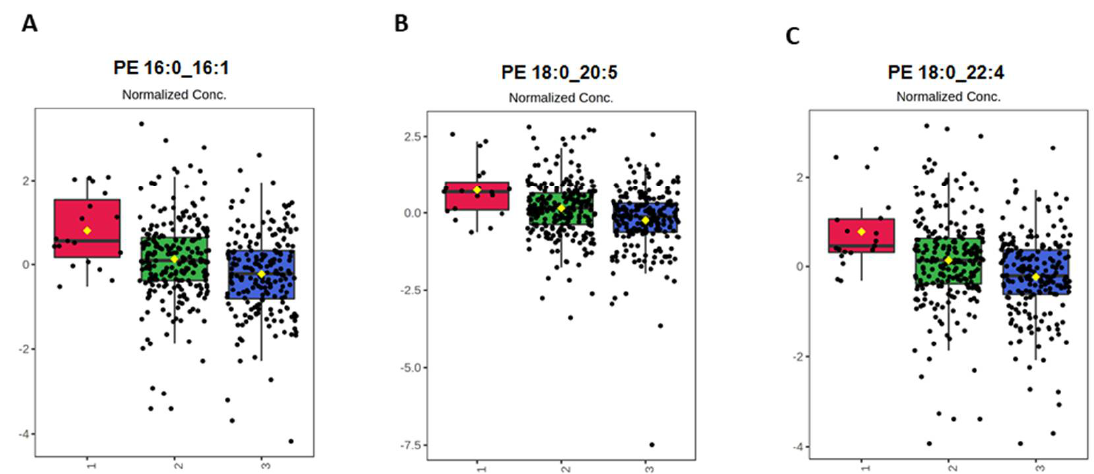
Figure 6. The top-three discriminant lipid species ( A ) PE 16:0_16:1, ( B ) PE 18:0_20:5, and ( C ) PE 18:0_22:4 across categories of CVH status. The boxplots show lipid species with VIP >1.7.